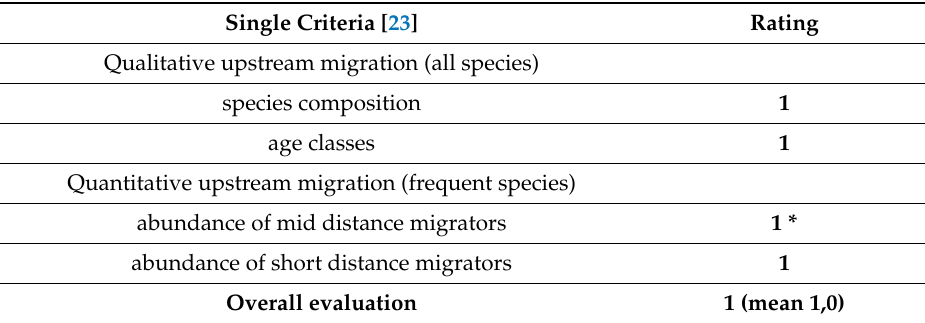
Table 4. Overall evaluation of passability